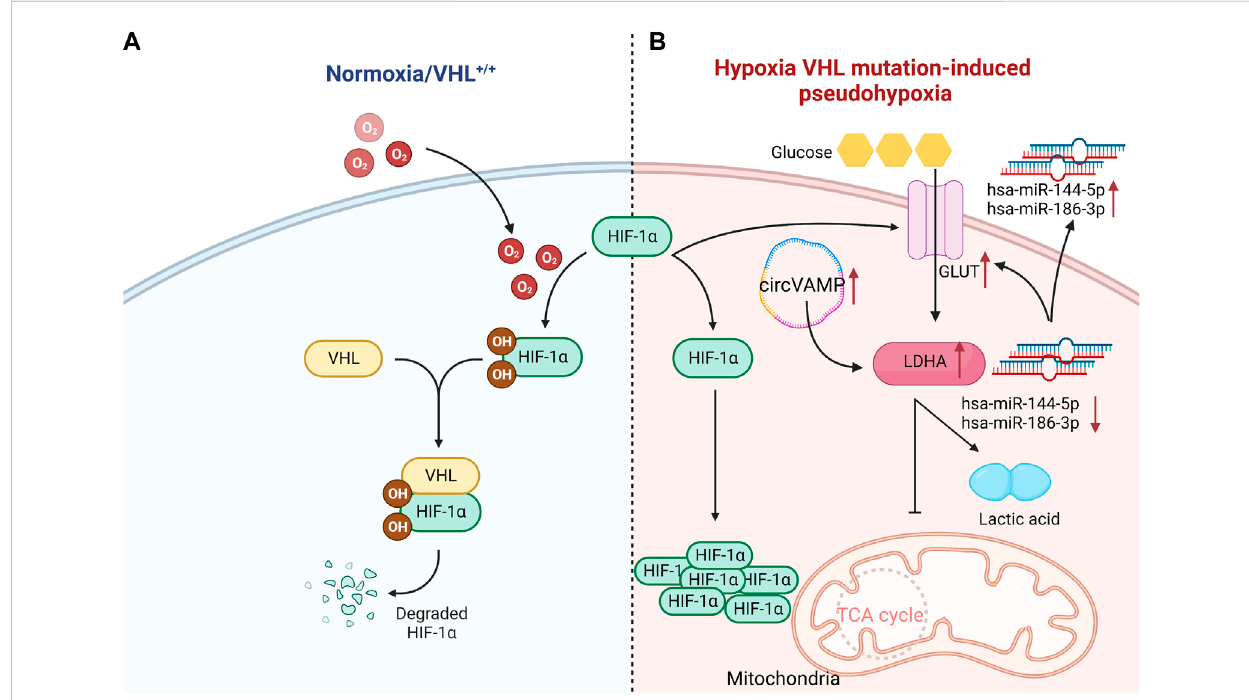
FIGURE 1 VHLnormallycodesHIF-1 α protein,andtargetsHIF-1 α transcriptionfactorsforproteosomedegradationunderaerobicconditions.OnceVHLislost, the degradation process of transcription factors will be weakened, leading to the accumulation of HIF-1 α transcription factors under normal oxygen conditions. Compared with normal renal tubular cells, the mutation mediated by VHL- HIF-1 α can up-regulate the expression of GLUT-1 in ccRCC cells. Hsa-miR-144-5p and hsa-miR-186-3p directly bind to 3 ’ UTR of GLUT-1 mRNA, and thus GLUT-1 expression in ccRCC is signi fi cantly increased. Meanwhile,circVAMPishighlyexpressedinccRCC,whichcombineswithLDHAtoinhibitTCAcycle,andthenpromotesglycolysistoproducelacticacid. Since the conversion of glucose into lactic acid produces less energy than oxidative phosphorylation, it is insuf fi cient to maintain the energy supply for cancer cells. Hence, more glucose will be consumed. ↑ :increase; ↓ :reduce; → :inhibition (Created with